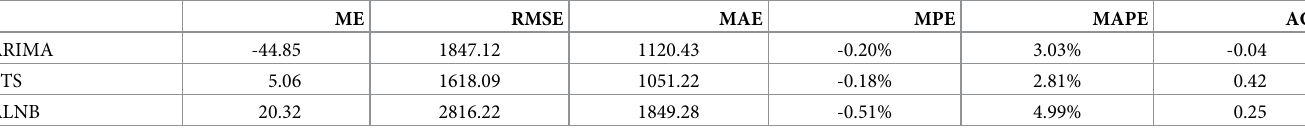
Table 2. Accuracy measures for the models over the Spanish data from January 2015 to December 2019.